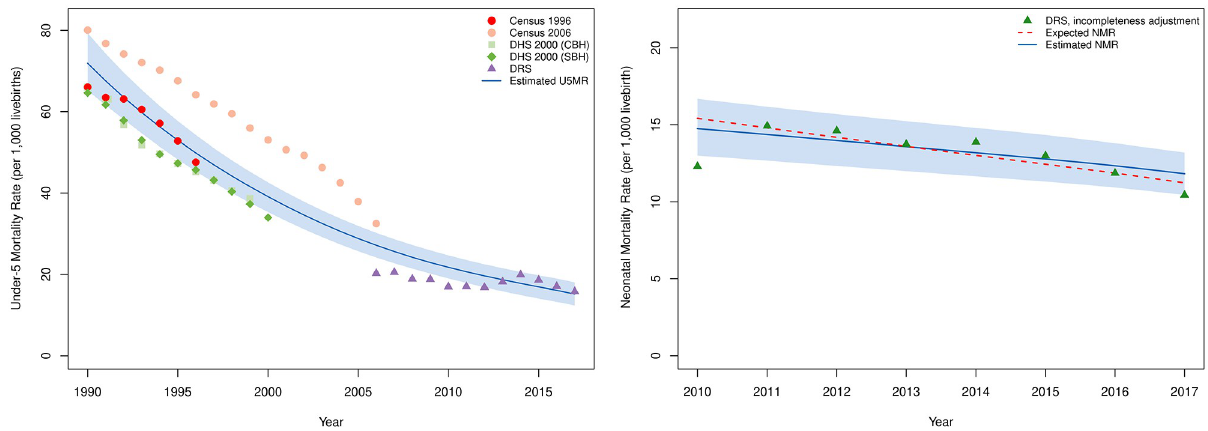
Fig 1. National trends of U5MR and NMR before 2017.